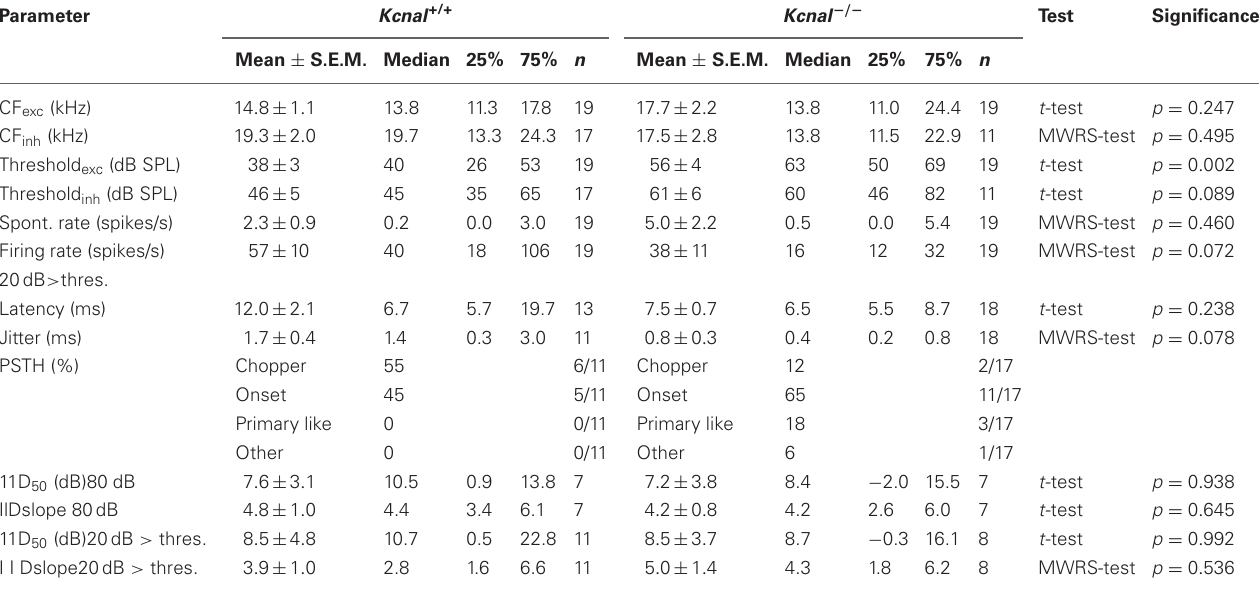
Table 1 | Response features of IID-sensitive IC neurons.